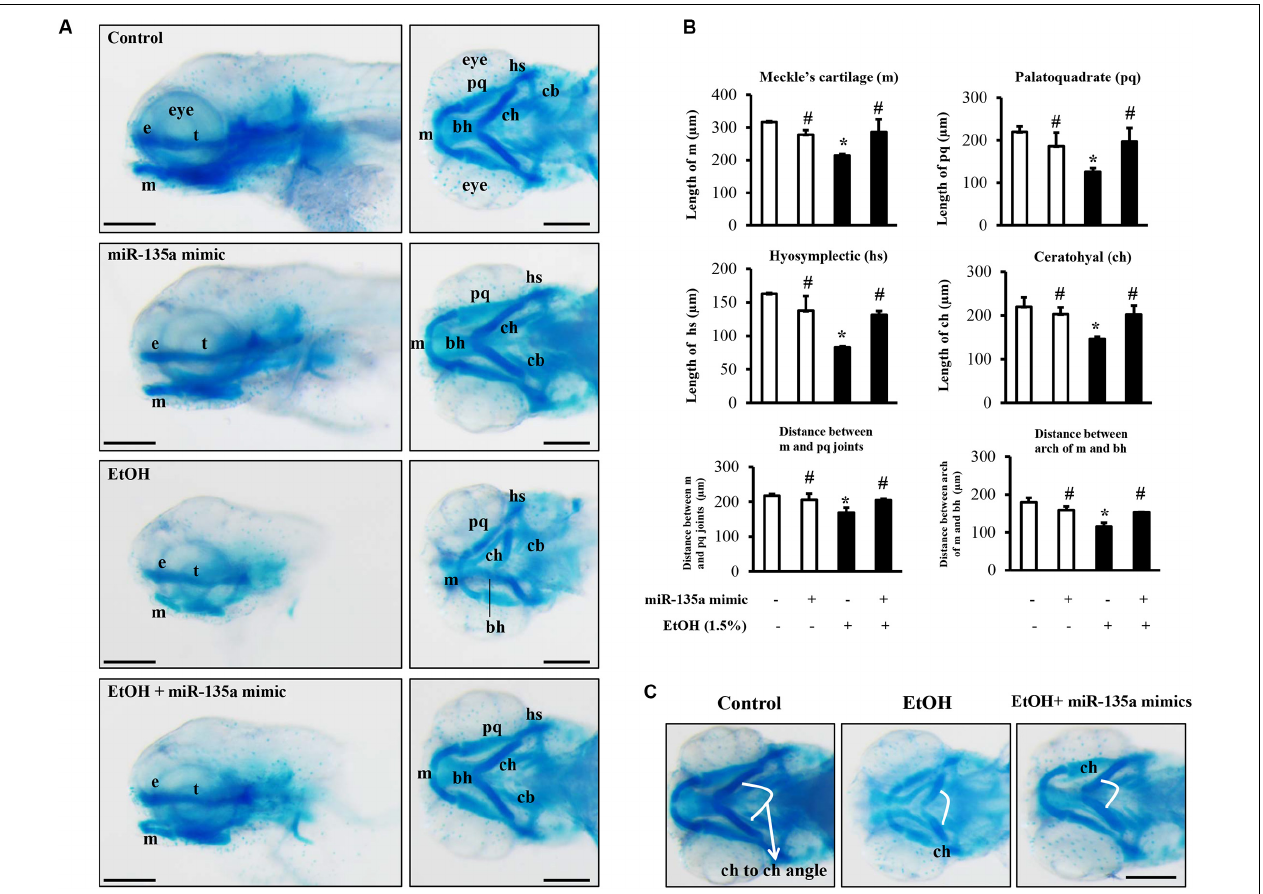
FIGURE 7 | Microinjection of miR-135a mimics attenuated ethanol-induced craniofacial cartilage defects in zebrafish larvae. Embryos microinjected with control or miR-135a mimics were treated with 1.5% ethanol from 3 h post-fertilization (hpf) to 24 hpf. Zebrafish larvae were collected at 5 days post-fertilization (dpf) for skeletal staining with Alcian blue. (A) Lateral and ventral view of Alcian blue-stained craniofacial cartilages in larvae from different treatment groups. (B) Morphometric analysis of the craniofacial cartilages in larvae from different treatment groups. The length of Meckel’s cartilage (m), palatoquadrate (pq), hyosymplectic (hs), ceratohyal (ch), and the distance between m and pq joint, and between the arch of m and basihyal (bh) were measured. (C) Comparisons of ceratohyal cartilage (ch) angle between different treatment groups. Data represent the mean ± SD of three separate experiments. * p < 0.05 vs. control; # p < 0.05 vs. ethanol. e, ethmoid plate; t, trabeculae cranii; cb, ceratobranchial; bh, basihyal. Scale bar = 200 µ